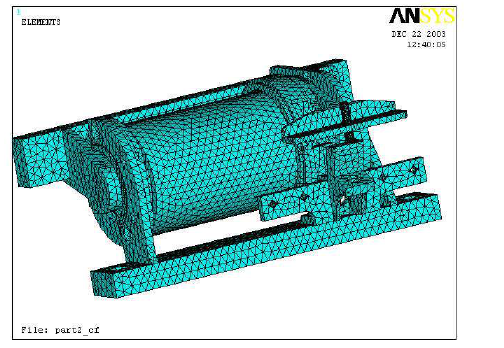
Fig. 10. Meshed Rotation Mechanism.